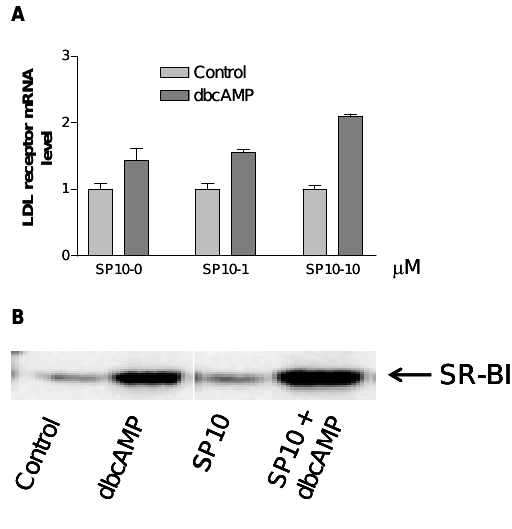
Figure 8. Effect of SP-10 on LDL-R mRNA levels and SR-BI protein levels. Y-1 cells were treated with the indicated concentration of SP10 for 24 h. They were then treated with 1 mM dbcAMP for 24 h. (A) LDL-R mRNA was quantified by Q-PCR. Results are presented as mean ± SD. (n ≥ 3 for each group). SP-10 at concentrations of 10  M significantly enhanced dbcAMP-induced increases in LDL-R mRNA levels (p < 0.01, ANOVA). B. SR-BI receptor protein levels were determined by immunoblot